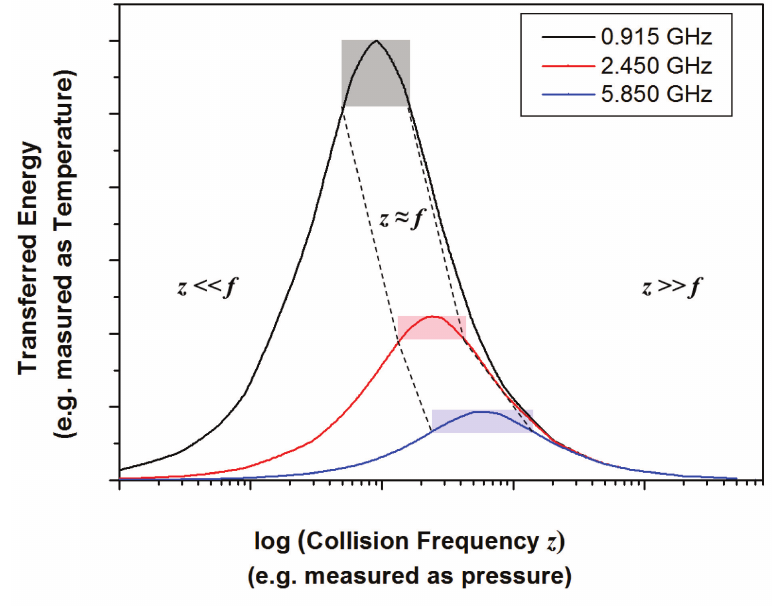
Figure 3. Transferred energy as a function of frequency, calculated using Equation